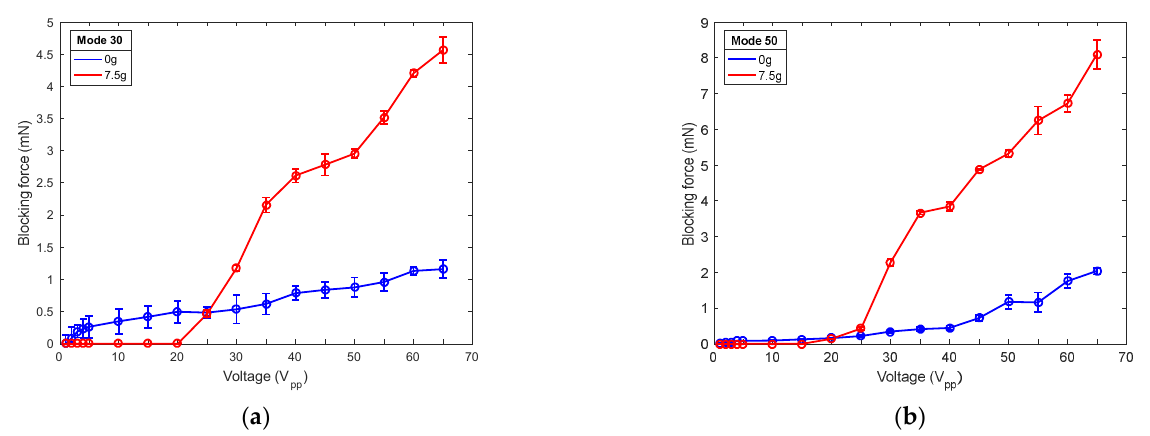
Figure 11. Blocking force of ( a ) the (30) mode-actuated robot and ( b ) the (50) mode-actuated robot, versus applied voltage for different masses: no load mass (blue), 7.5 g (red).